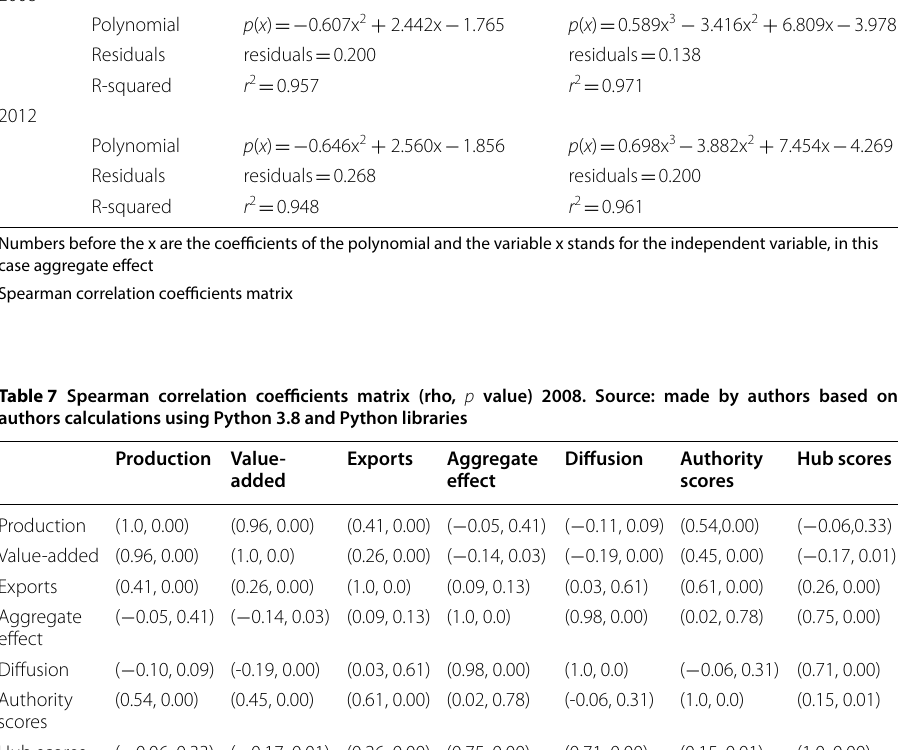
Table 6 Fitting polynomials for the curves of aggregate effect and diffusion. Source: made by authors based on authors calculations using Python 3.8 and Python libraries Degree 2 Degree 3